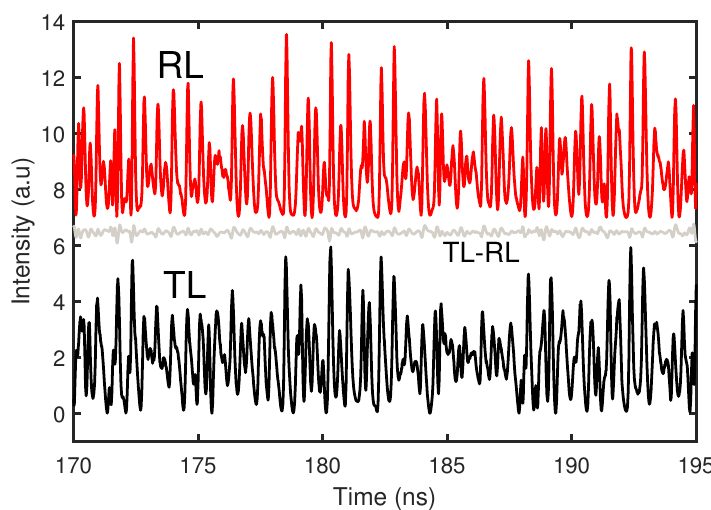
Figure 1. Time traces of the transmitter and receiver lasers: The black (red) traces correspond to TL (RL) output (chaotic intensity including message signal) respectively for J m = 1.10 I th , J R = 1.08 I th ,